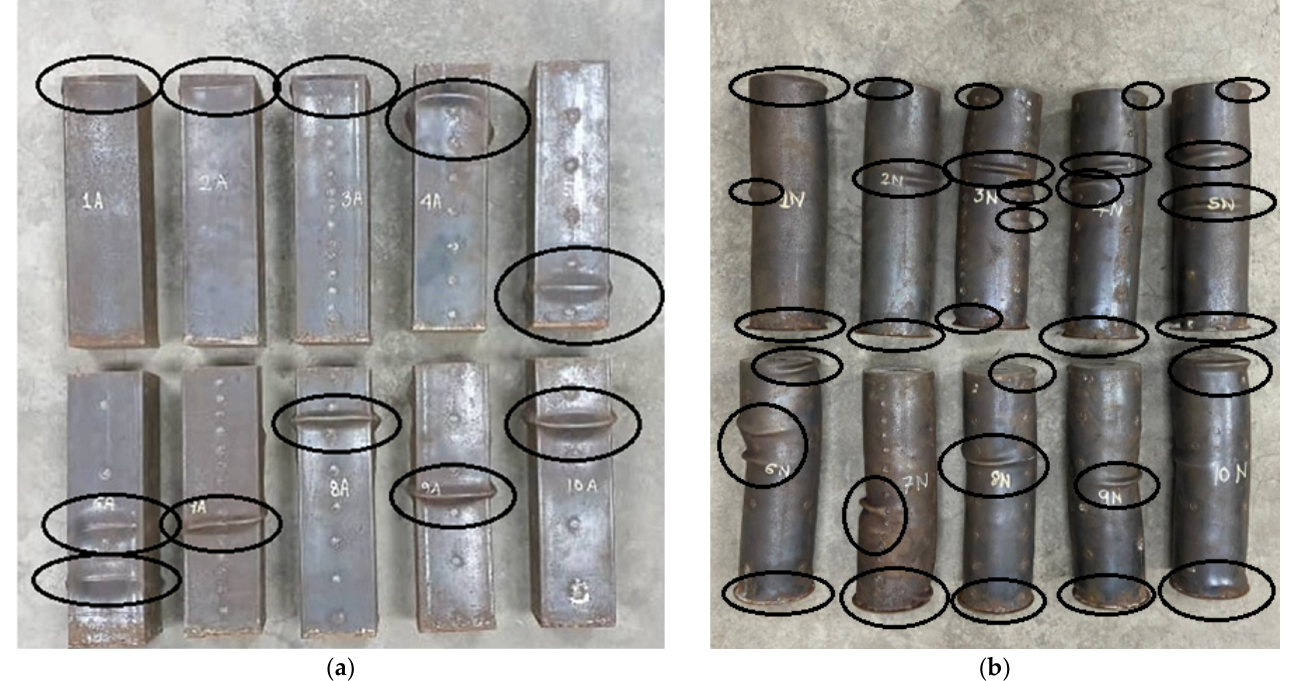
Figure 8. Failure modes of the square and circular specimens. ( a ) Square specimens. ( b ) Circular